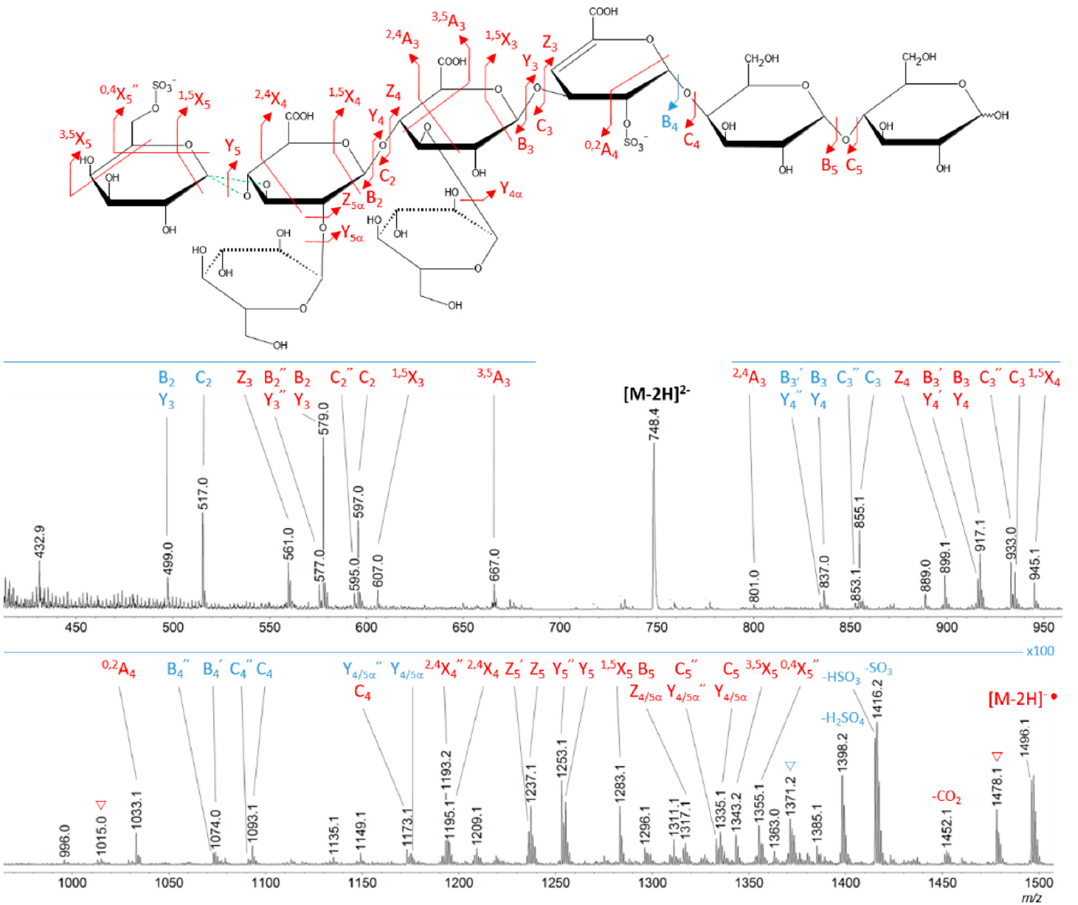
Figure 6. Helium charge transfer dissociation (He-CTD) tandem MS spectrum of the structure A isolated as a [M − 2H] 2 − species at m / z 748.4 in negative ionization mode. For better readability, the mass range was split into two parts. Red, fully sulfated fragments; Blue, fragments with one sulfate loss; Triangle, water losses.